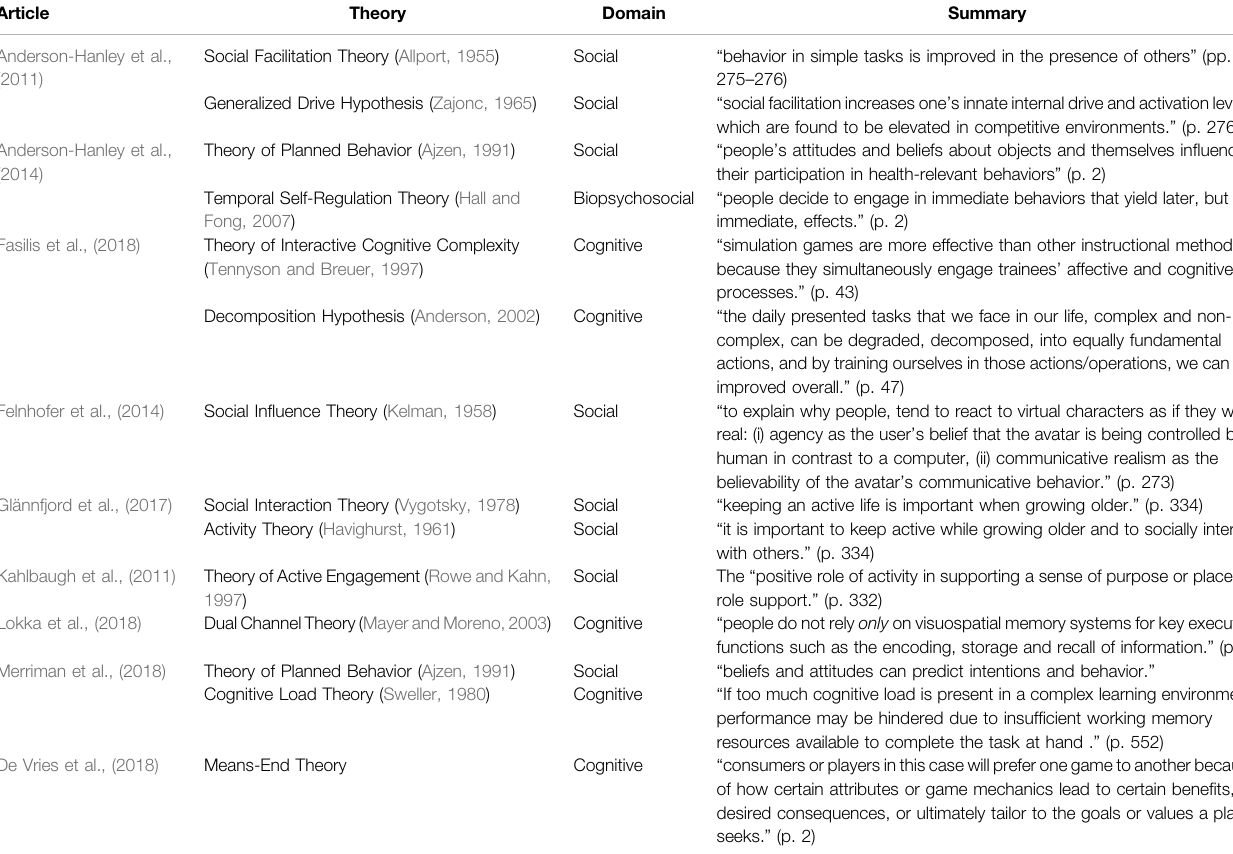
TABLE 6 | Theories supporting AR/VR